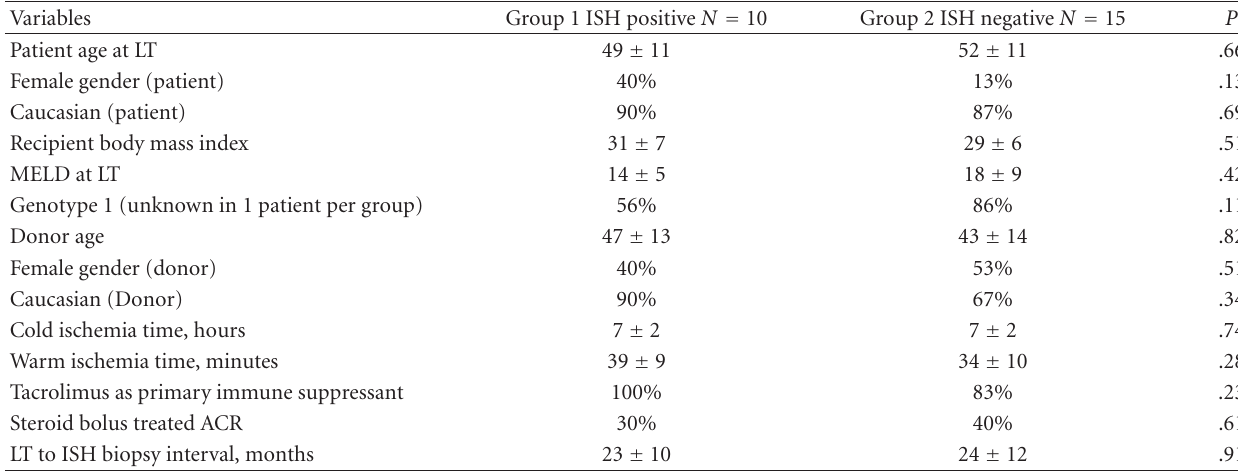
Table 1: Patient and donor characteristics, and antiviral therapy at the time the ISH biopsy in HCV ISH positive (group 1) and negative (group 2) patients.